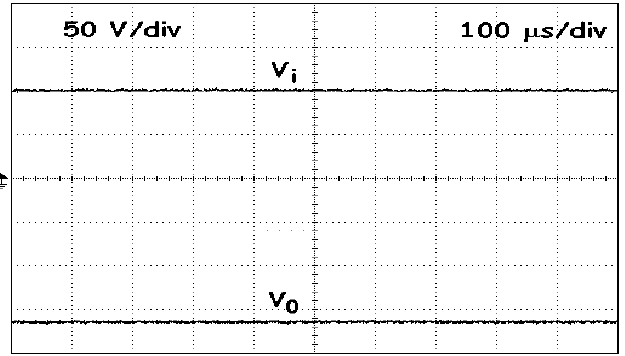
Figure 20. Experimental results for the input and inverted output voltage in boost mode (0.7).